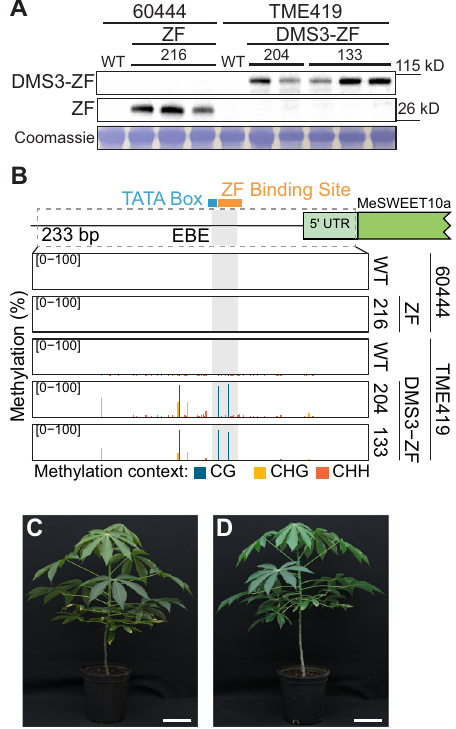
Fig. 2 | DMS3-ZF expression results in CG methylation at the EBE in vivo. A Expression of transgenes in individual plants from two independent DMS3- expressing transgenic lines (133 and 204) as well as a ZF-only negative control line (216). Cassava variety information for each sample is given above the lanes. First two rows: representative western blots (anti-FLAG) showing expression of the ZF (ZF-3xFLAG) protein with (top) and without (middle) DMS3. Relevant size stan- dards are shown to the right (kD). Bottom: Coomassie Brilliant Blue stained Rubisco, loading control. Uncropped images of the western and Coomassie are shown in Supplementary Fig. 5A. B Representative PCR-based bisul fi te sequencing (ampBS-seq) results from samples shown in ( A ). Details results for these samples are shown in Supplementary Fig. 5A. Top: Graphical depiction of MeSWEET10a promoter region assessed for methylation. The EBE (gray), a presumed TATA box (blue) and the ZF binding site (orange) are indicated. The predicted 5 ′ UTR and MeSWEET10a transcriptional start site are shown in green. The area within the dottedlinedbox(233bp)wassubjectedtoampBS-seq.Bottom:CG,CHG,andCHH DNA methylation levels (percent, y -axis) of the MeSWEET10a promoter (EBE, gray) measuredbyampBS-seqwithandwithoutDMS3-ZF.Backgroundoftissueforeach plot is indicated to the right. Methylation was called for cytosines with >500 reads mapped. The results in ( A and B ) are representative examples of the six indepen- dent experiments presented in Supplementary Figs. 2 – 7. C Representative wild- type (TME419) and ( D ) DMS3-ZF-expressing (line #133) plants. Scale bar=14cm. Additional data quantifying growth in the fi eld are shown in Supplementary Fig. 8. Source data are provided as a Source Data fi